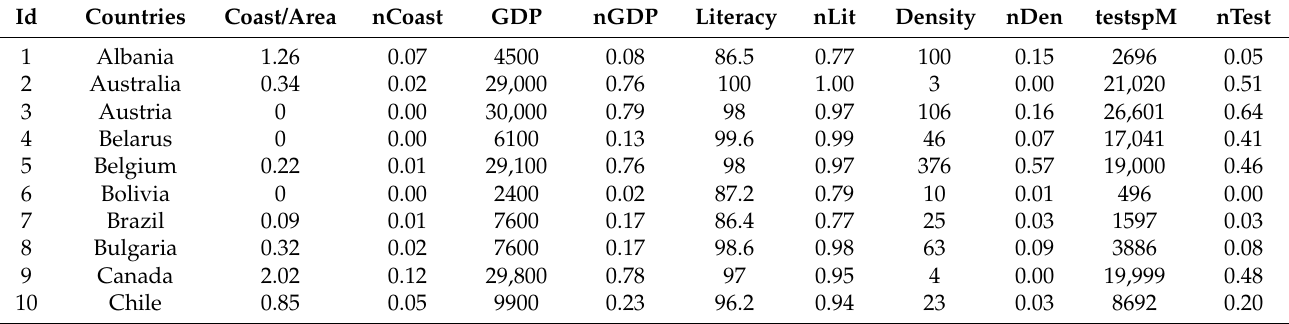
Table 1. Countries and feature selection, example of top 10 entries. Snapshot of list of 51 countries processed for similar characteristics using filter parameter clustering. Columns: countries (name), coast/area (ratio), GDP (in US$), literacy (per- centage), density (pop/km 2 ), tests pM (coronavirus tests). Column names starting with “n” signify min-max normalization of the corresponding attribute. Available as Data Supplement 1